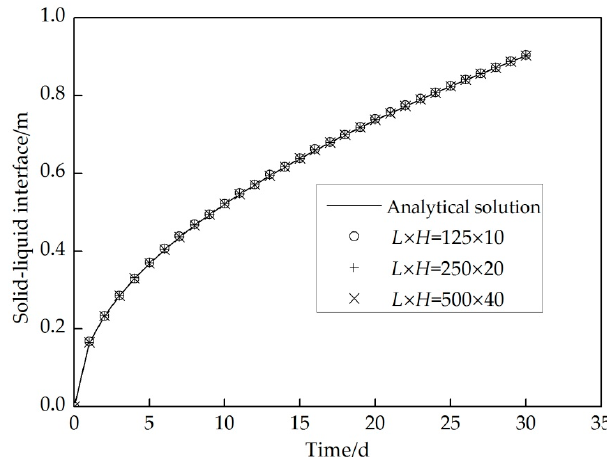
Figure 4. Comparisons between lattice Boltzmann method (LBM) and analytical solutions for the solid–liquid interface. Energies 2018 , 11 , x FOR PEER REVIEW